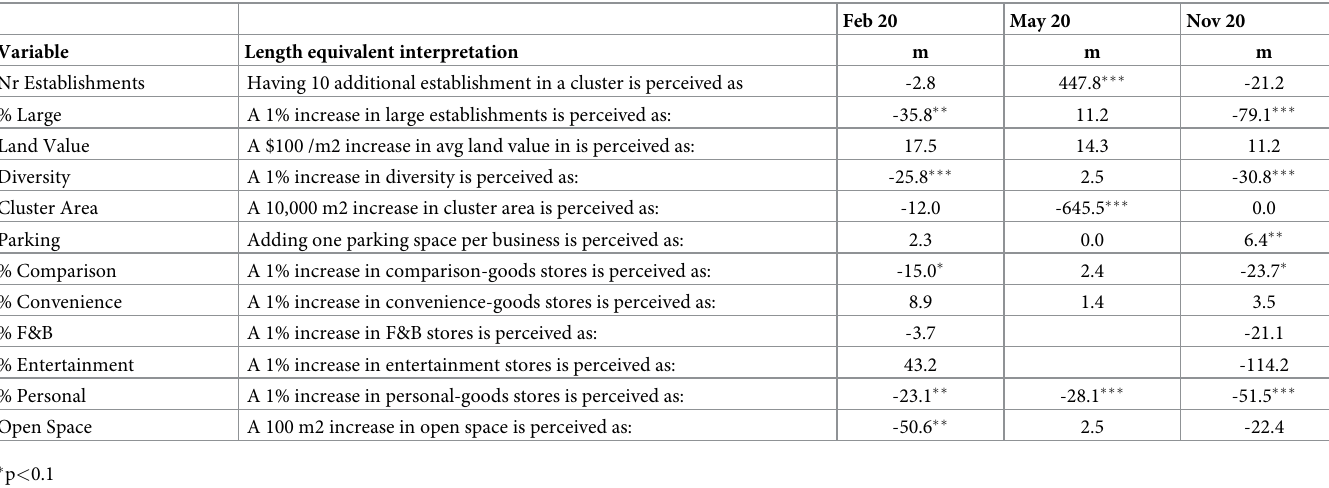
Table 4. Distance-equivalent effects of cluster attributes in February, May and November